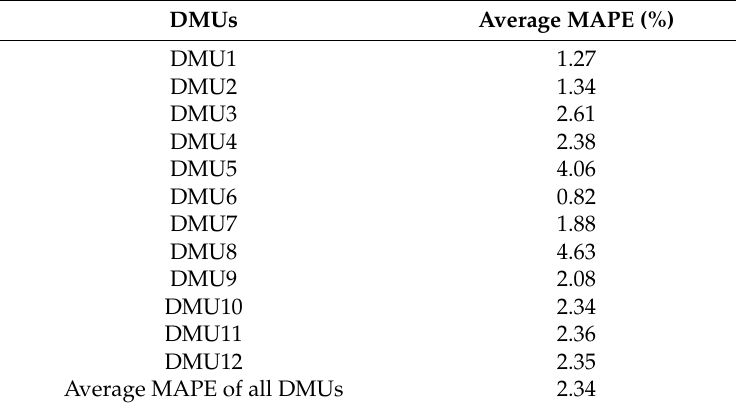
Table 10. Average MAPE of